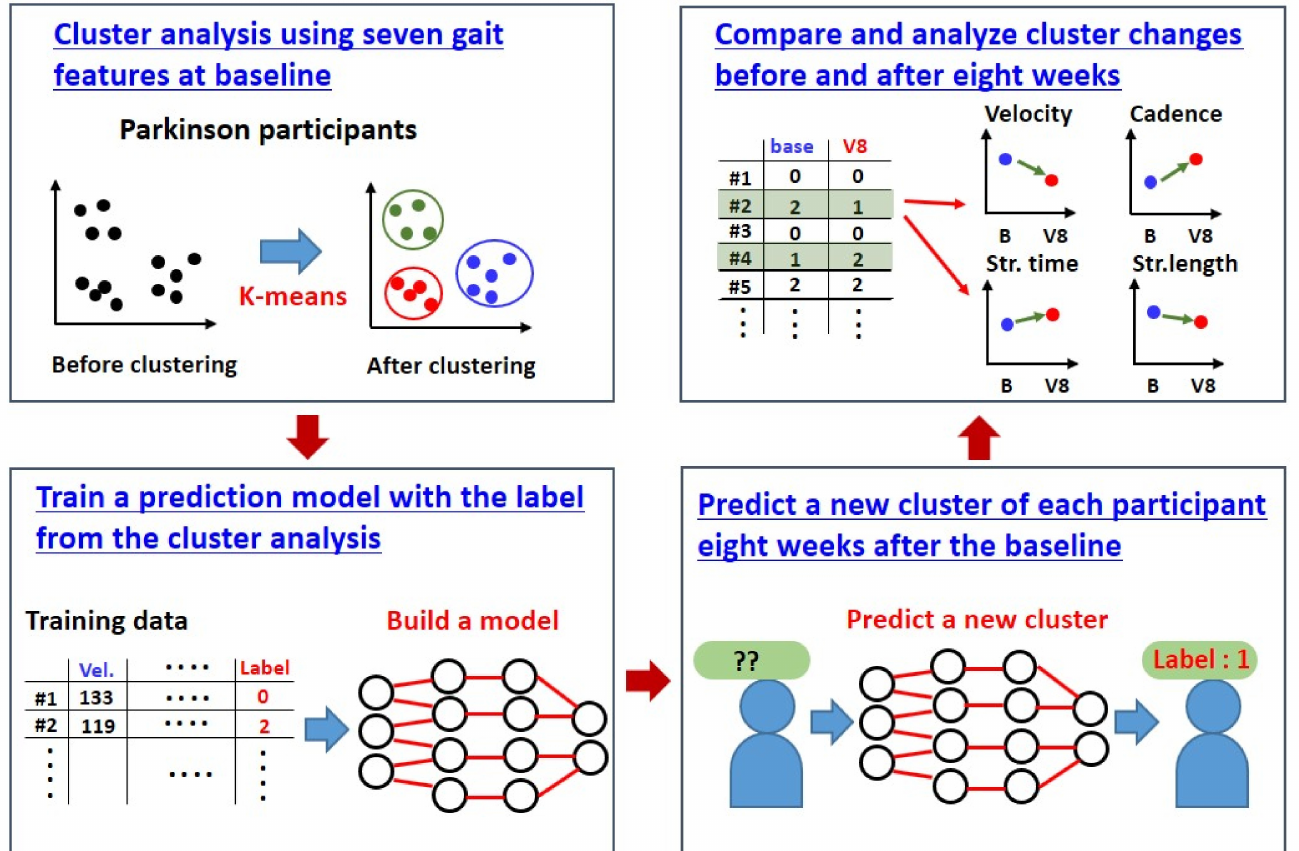
Figure 3. The cluster change prediction process with machine